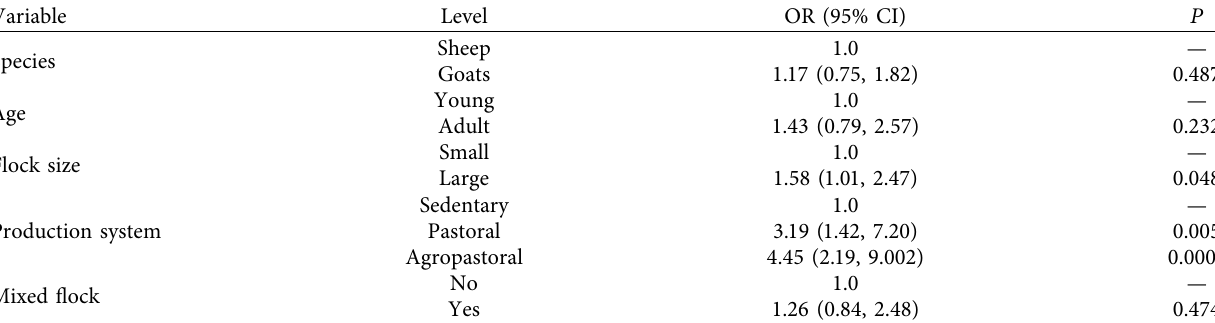
Table 3: Multivariable logistic regression analyses of potential risk factors of small ruminant